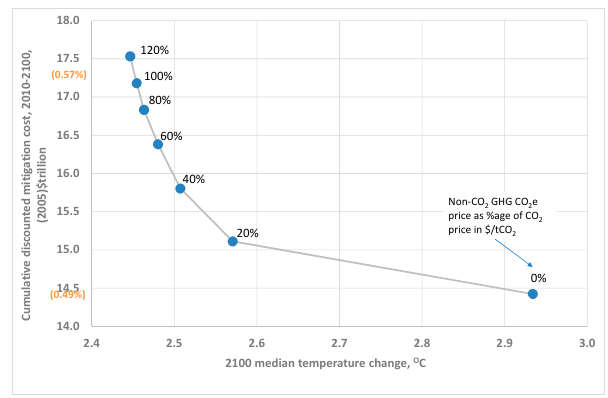
Figure 8. Cost of meeting 2100 temperature change levels with non-CO 2 GHG mitigation at a range of CO 2 e prices relative to CO 2 mitigation, 2.5 °C scenario with delayed action to 2020. Notes: Figures in parenthesis on Y-axis show costs as a share of cumulative 2000–2100 discounted GDP (at 5% per year discount rate).